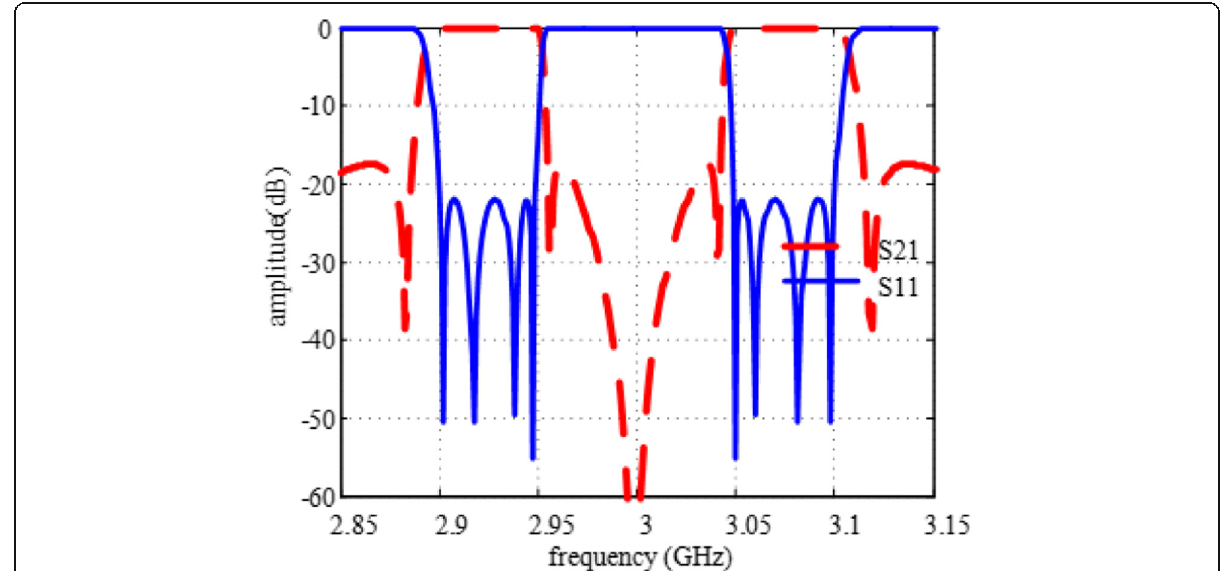
Fig. 5 S parameters response curve of dual-passband actual frequency